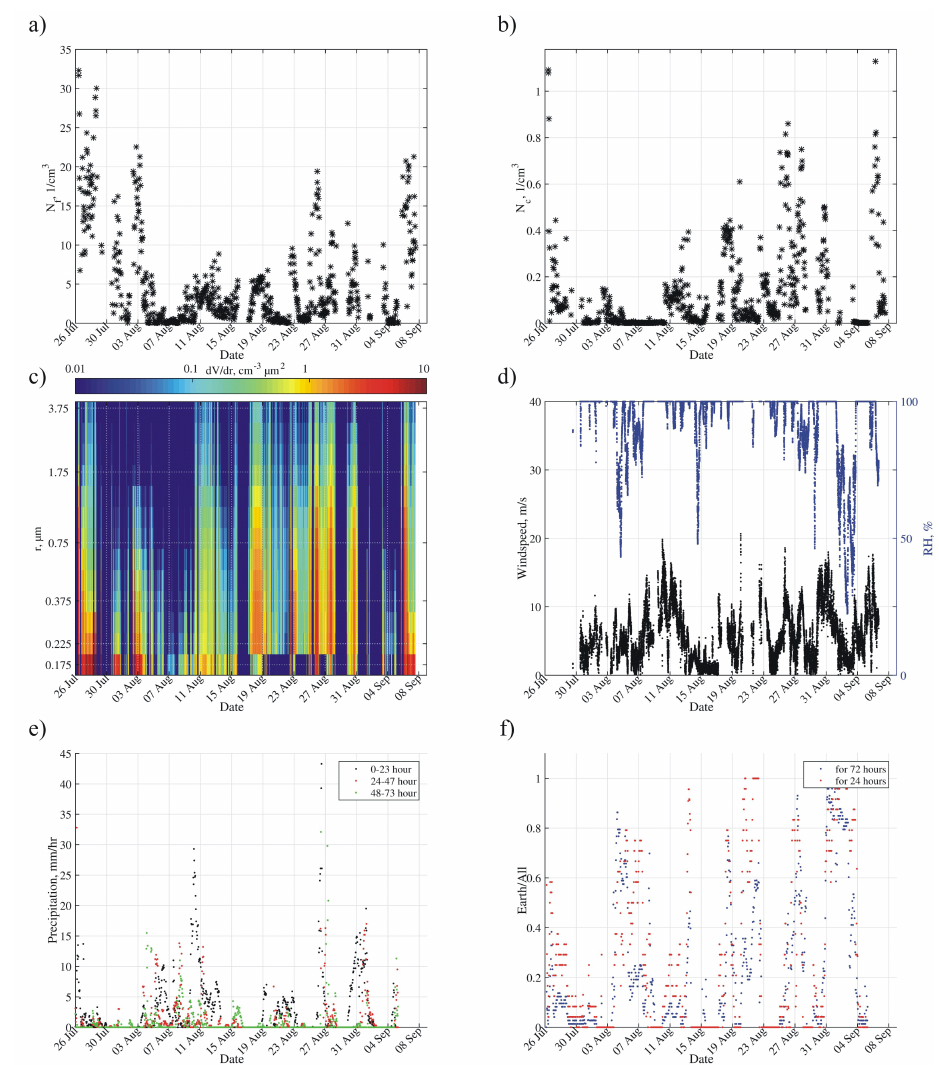
Figure 9. Temporal behavior of the (a) number concentrations of submicron N f and (b) coarsely dispersed N c aerosol fractions; (c) the volume particle size distributions d V/ d r ; (d) the wind speed (black) and the relative air humidity (blue); (e) the along-trajectory rainfall amount; and (f) the fraction of trajectories passing over